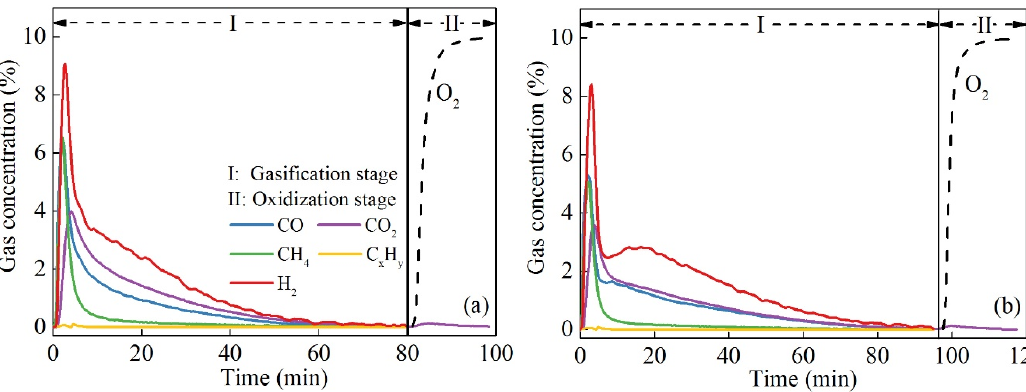
Figure 6. The distribution of outlet gases obtained from ( a ) the sample with 64 wt.% cyanobacteria; ( b ) the sample with 46 wt.% cyanobacteria under 900 ° C and a 0.3 oxygen carrier-to-fuel ratio.